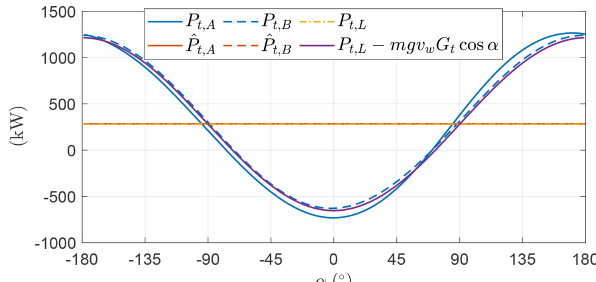
Figure 13. Optimal thrust power production and consumption P t as a function of the angular position.